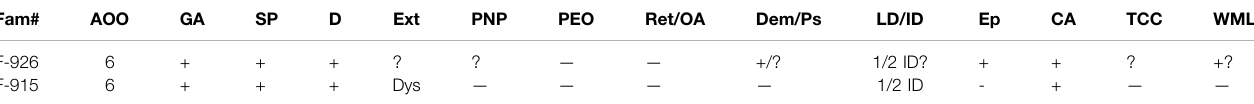
TABLE 2 | The main clinical characteristics of patients from the two families included in this study.